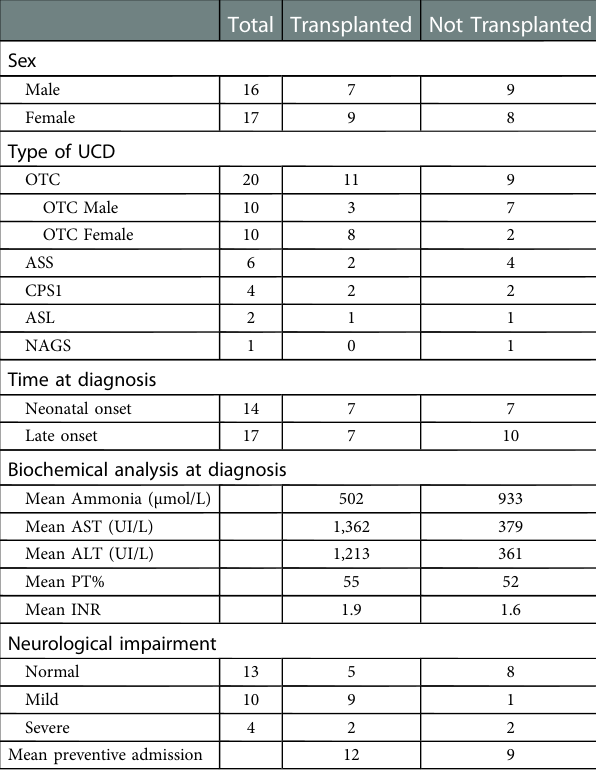
TABLE 1 Patients transplanted and not-transplanted by UCD-type and characteristics. Total Transplanted Not